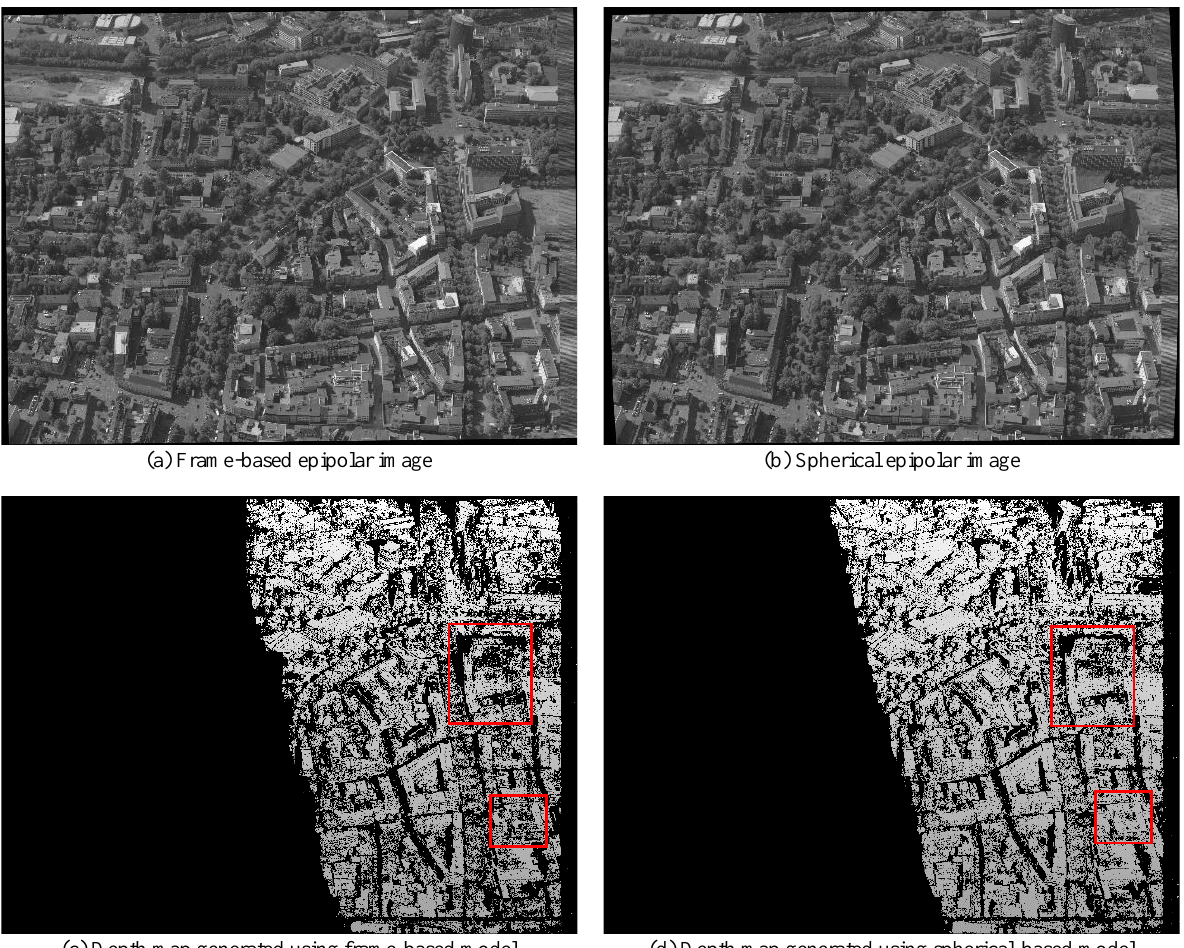
Figure 3 . Comparison of depth maps computed using the proposed spherical model compared to frame-based rectification. Top row shows the epipolar images. The outlined regions show examples of a more complete depth map generated by the proposed spherical model compared to frame-based